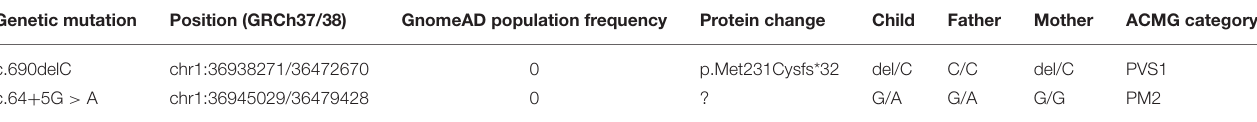
TABLE 1 | Mutations in CSF3R (NM_000760.3) identified in the patients with congenital severe neutropenia type 7. Genetic mutation Position (GRCh37/38) GnomeAD population frequency Protein change Child Father Mother ACMG